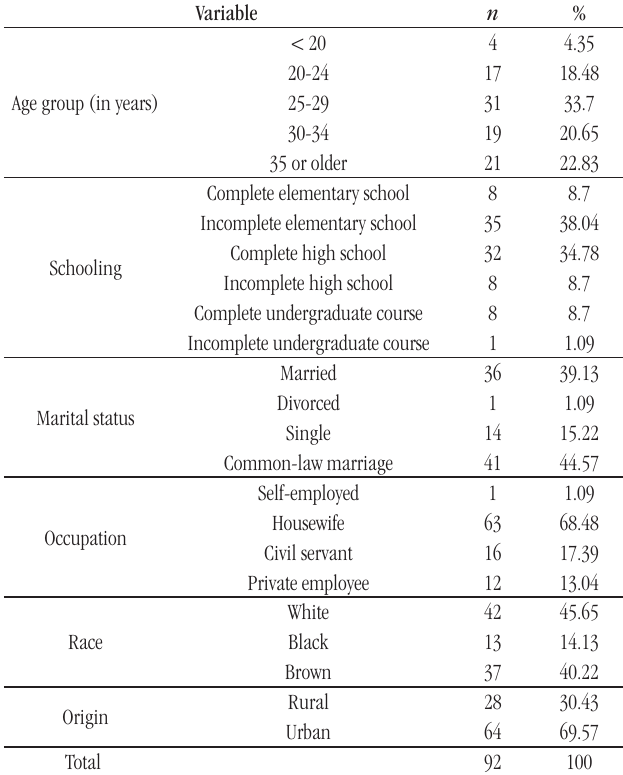
table 1 – Sociodemographic profile of pregnant women seen at a maternity hospital in the municipality of Caruaru ( n = 92)